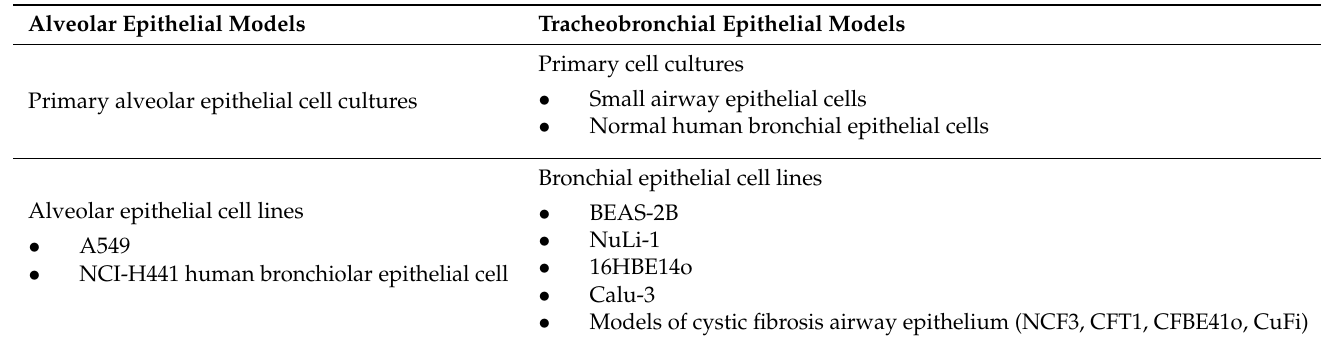
Table 5. In vitro models for absorption of inhaled drug particles [33]. Tracheobronchial Epithelial